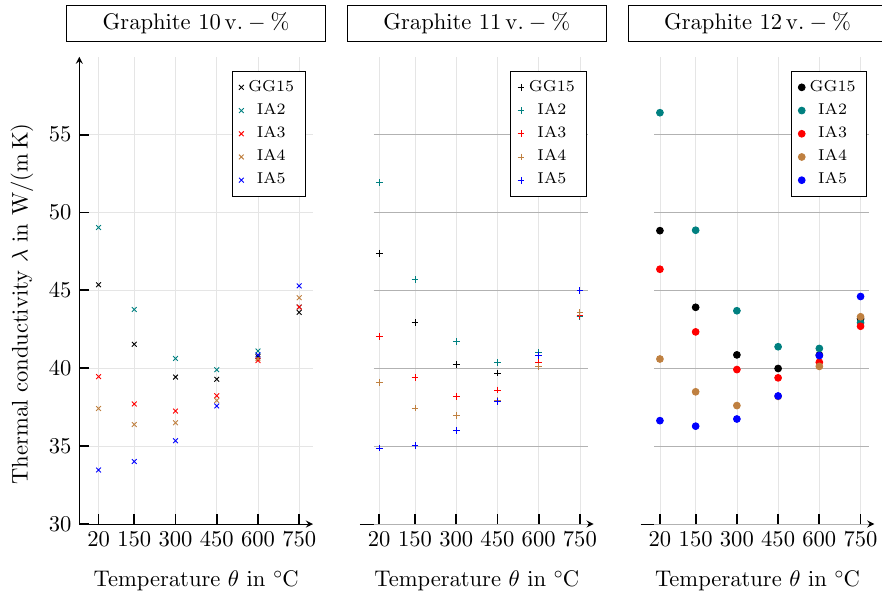
Figure 30. Thermal conductivities of all graphite classes with graphite flake volume fractions of 10, 11 and 12v. %, for the temperatures 20, 150, 300, 450, 600 and −